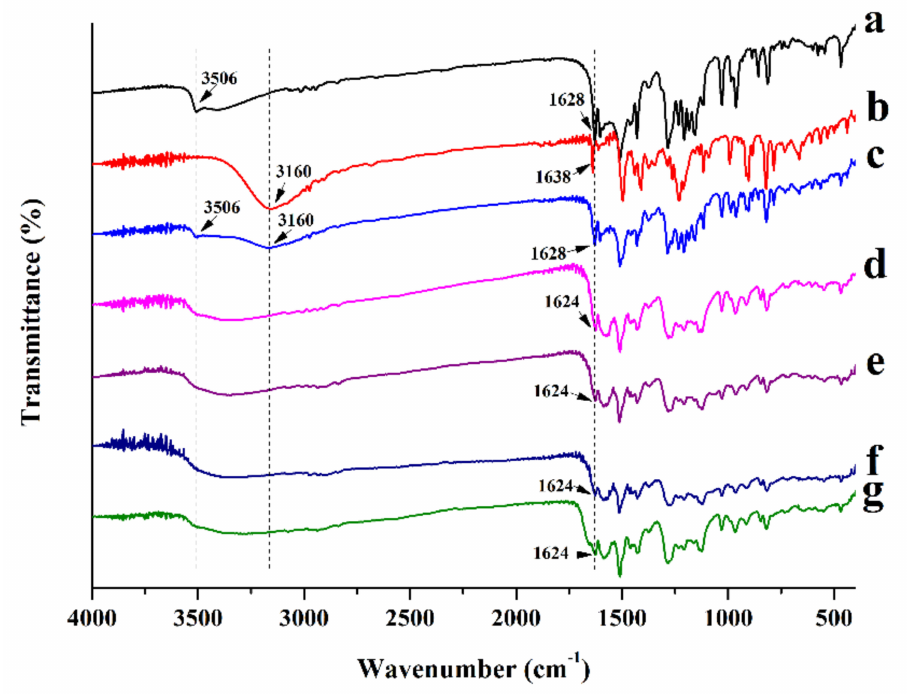
Figure 5. FTIR spectra: ( a ) crystalline CUR; ( b ) crystalline MAG; ( c ) CUR-MAG PM; ( d ) CUR-MAG CM; ( e ) CUR-MAG-HPMC CM; ( f ) CUR-MAG-HPC CM; ( g ) CUR-MAG-PVP K30